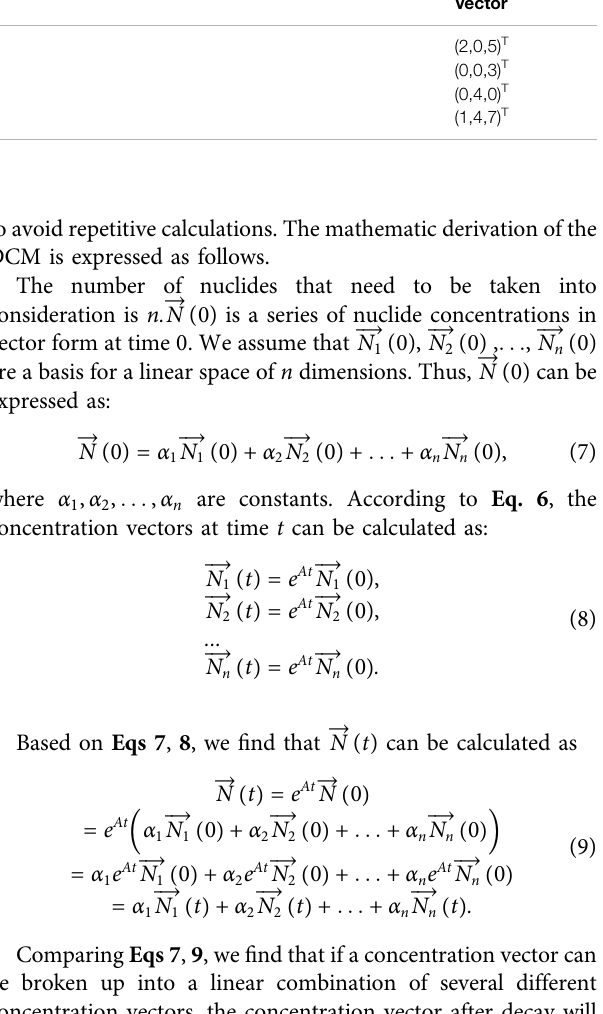
TABLE 1 | Initial nuclide concentration vectors in the four decay regions. Decay region